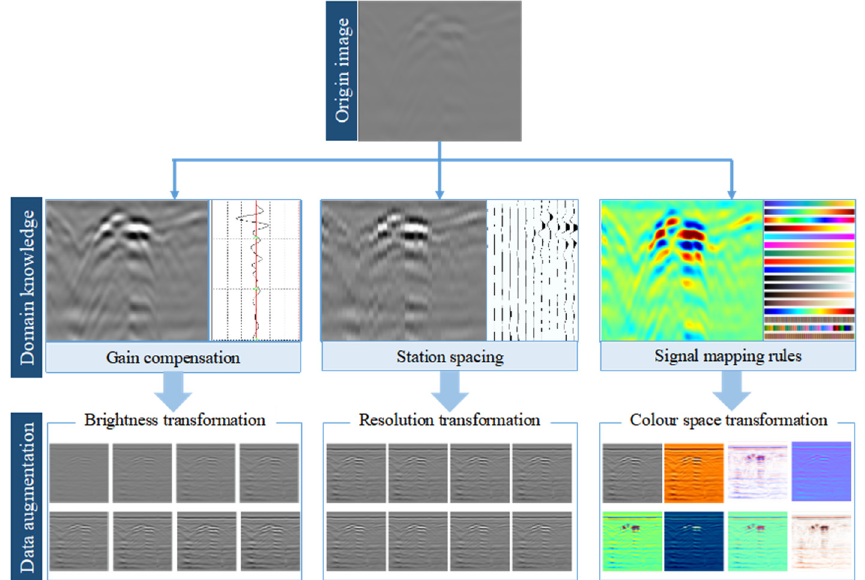
Figure 1. GPR data augmentation methods by incorporating domain knowledge: image brightness transformation based on gain compensation, image resolution transformations based on station spacing, and color space transformations based on radar signal mapping rules.